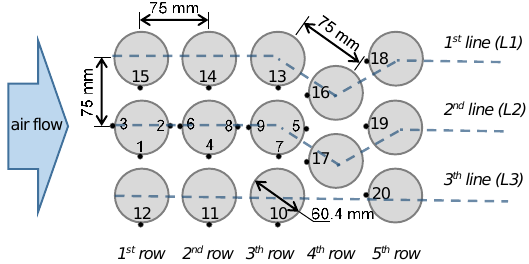
Figure 1. Mixed configuration proposed in the current study.